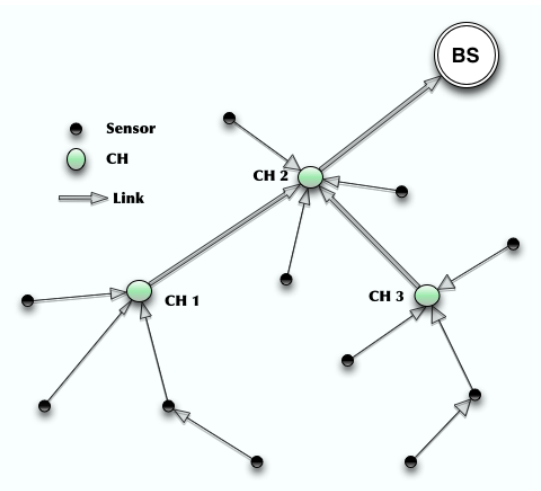
Figure 1. An Example of Cluster-Based